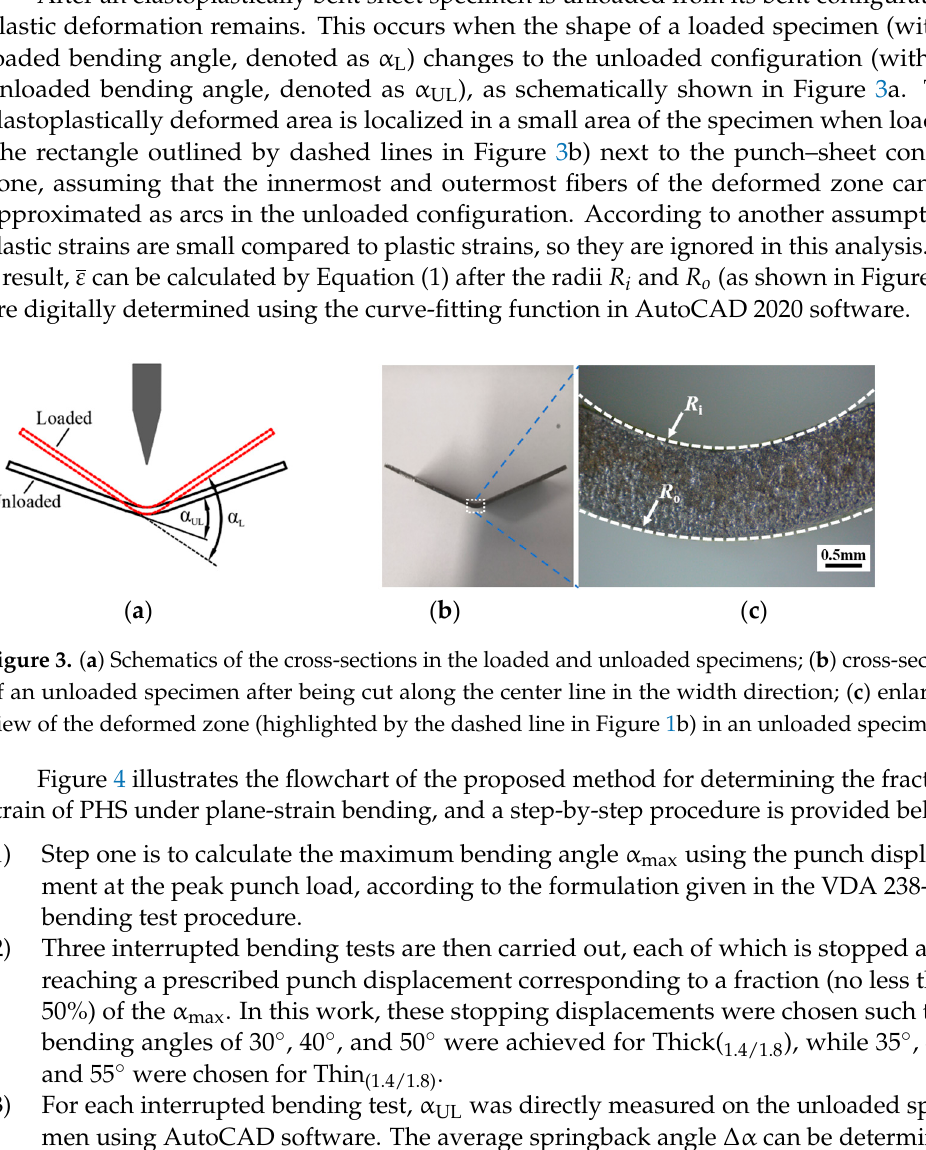
Figure 2. ( a ) SEM micrograph of the cross-section of a bent PHS specimen after heat treatment; ( b ) cracks in the Al–Si coating (the enlargement of the yellow rectangle in ( a )).